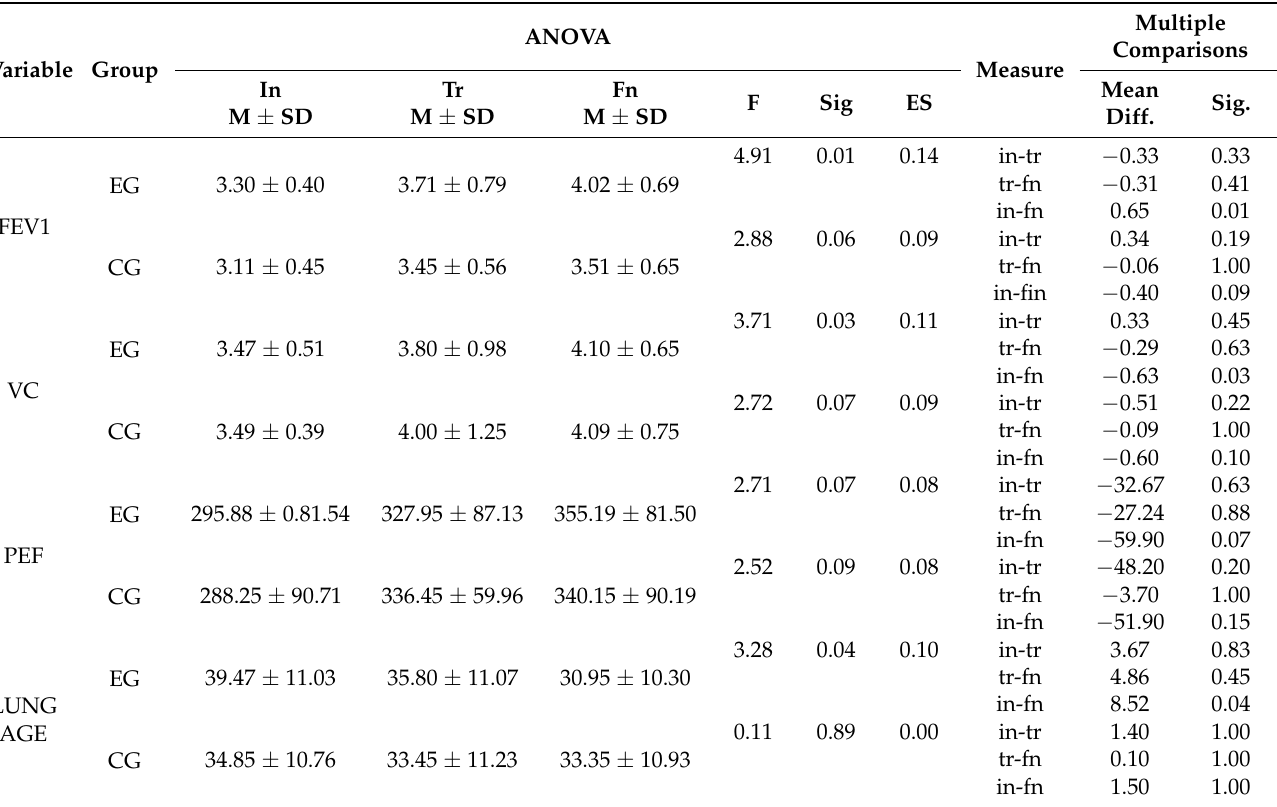
Table 2. Difference between measurements (initial, transit, and final) within groups (EG and CG group) for respiratory function.